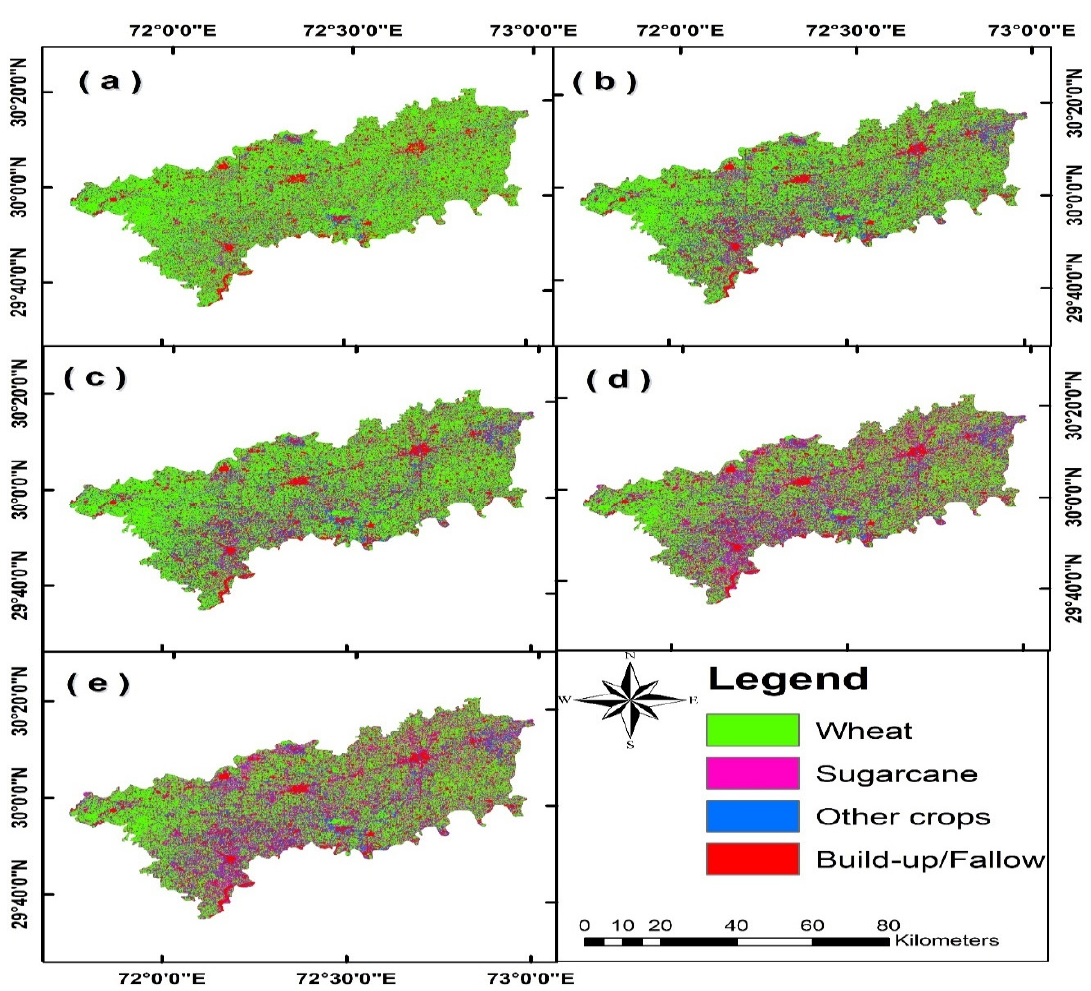
Figure 4. Crop identification map for Rabi season ( a ) 1984 ( b ) 1993 ( c ) 2002, ( d ) 2011 and ( e ) 2020. In Kharif seasons, cotton was a key crop in District Vehari, with a total cropped land from 40.2% in 1984 to 31.1% in 2020. Cotton area decreased by 9.1% from 1984 to 2020 in District Vehari (Figure 6). The Rice area was observed to cover 14.3% and 18% during 1984 and 2020, respectively, in the study area. The cultivated area under rice increased by almost 4% from 1984 to 2020. Another crop area, maize, was observed at 16.5% and 26.8% between 1984 and 2020 in the Kharif season (Figure 7). In the study area, the sugarcane area was observed at 17.3% and 15.3% during 1984 and 2020, respectively. The cultivated area under sugarcane decreased by almost 2% from 1984 to 2020. The building/fallow land increased from 9.1% to 10.2% from 1984 to 2020 in the study